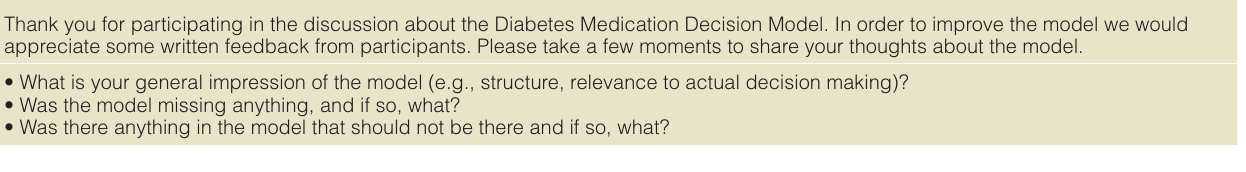
Supplementary Table 1. Open-ended questions to obtain feedback on initial model. Diabetes Medication Decision Model: feedback